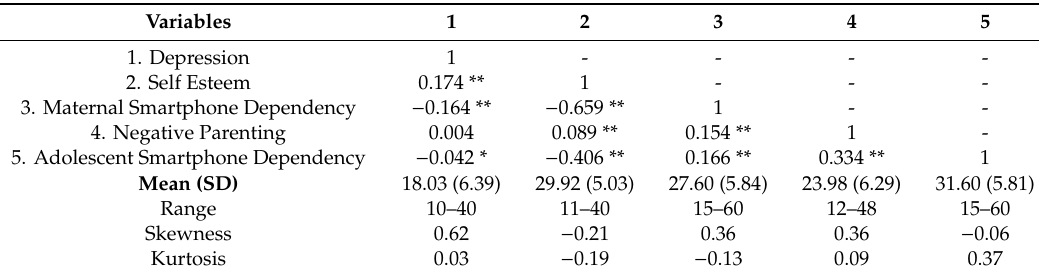
Table 1. Means, standard deviations and correlations for the variables by adolescent